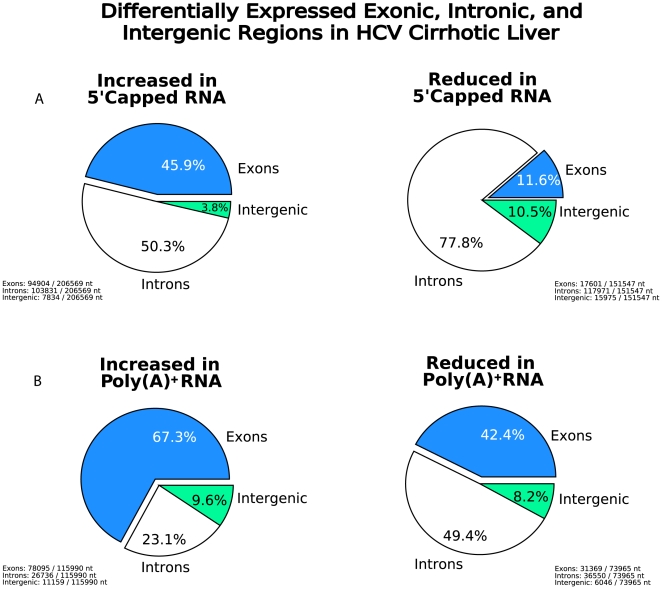
Differential gene expression observed in exonic, intronic, and intergenic
regions in 5′ capped and poly(A)+ RNA.Pie charts depict the relative percentage of differentially expressed
nucleotides in HCV cirrhotic liver as compared to control liver using
5′ capped RNA (Panel
A) or poly(A)+ RNA analysis (Panel
B). Charts on the left show increased expression and charts on
the right show reduced expression. The percentage of differentially
expressed nucleotides found in intronic, exonic, and intergenic regions are
shown for 5′ capped and poly(A)+ RNA samples.